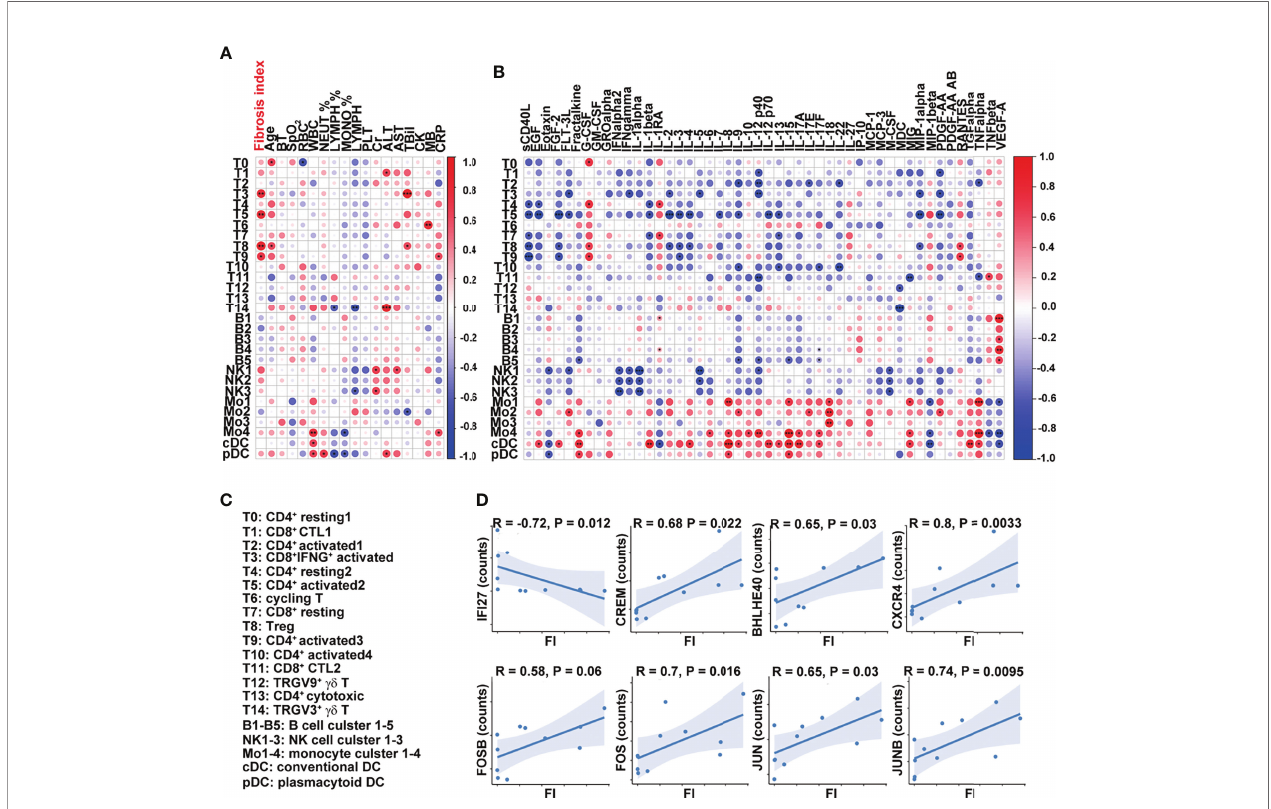
FIGURE 5 | Dysregulated T-cell activation and differentiation in patients with severe COVID-19. (A, B) Correlation map reporting Pearson or Spearman correlation values for the comparison of the ratios of various PBMC cell clusters and clinical measures, including FI. (C) Lists of the names of the cell clusters. Correlation map reporting Pearson or Spearman correlation values for the comparison of the ratios of various PBMC cell clusters and cytokines. The color of the Correlogram is based on Pearson ’ s or Spearman ’ s coef fi cient values calculated for each couple of measurements in the matrix. Red and blue colors represent positive correlation and negative correlation, respectively. The darker color means the stronger correlation. The following terminology is used to denote the statistical signi fi cance: * p < 0.05, ** p < 0.01, *** p < 0.005; ns, not statistically signi fi cant. (D) Correlation analysis of FI and the expression levels of indicated genes in T cells. The in fl ammation- related genes were selected in the analysis and the ones with signi fi cant correlation with FI were shown. Sample 07 was not included in the correlation analysis as its fi brosis index was 0.7, much higher than the rest of the samples